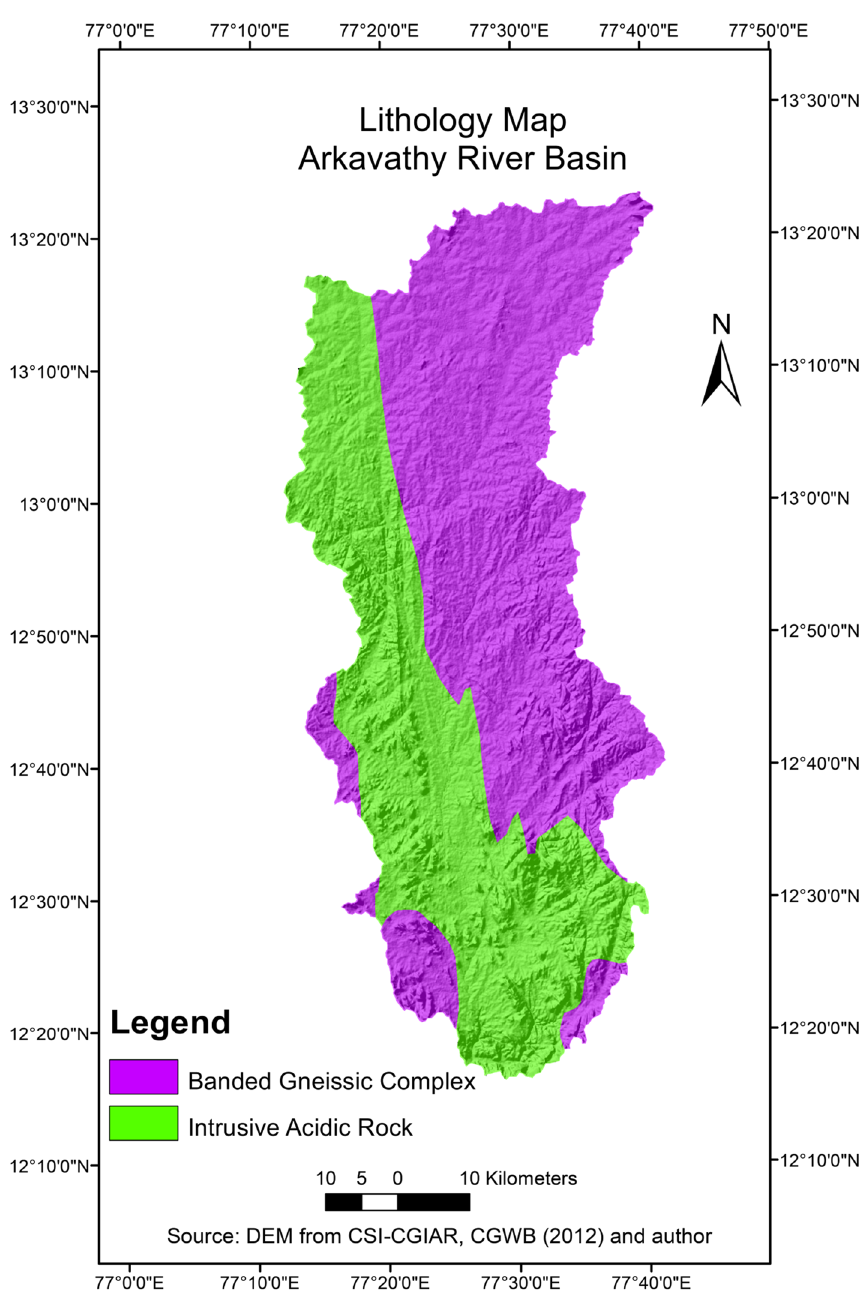
Fig. 8 Lithology in Arkavathy river